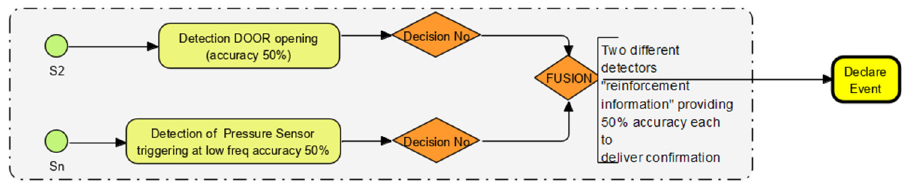
Figure 4. How one sensor data point and another sensor data point “collaborate” and “corroborate” to confirm an event.